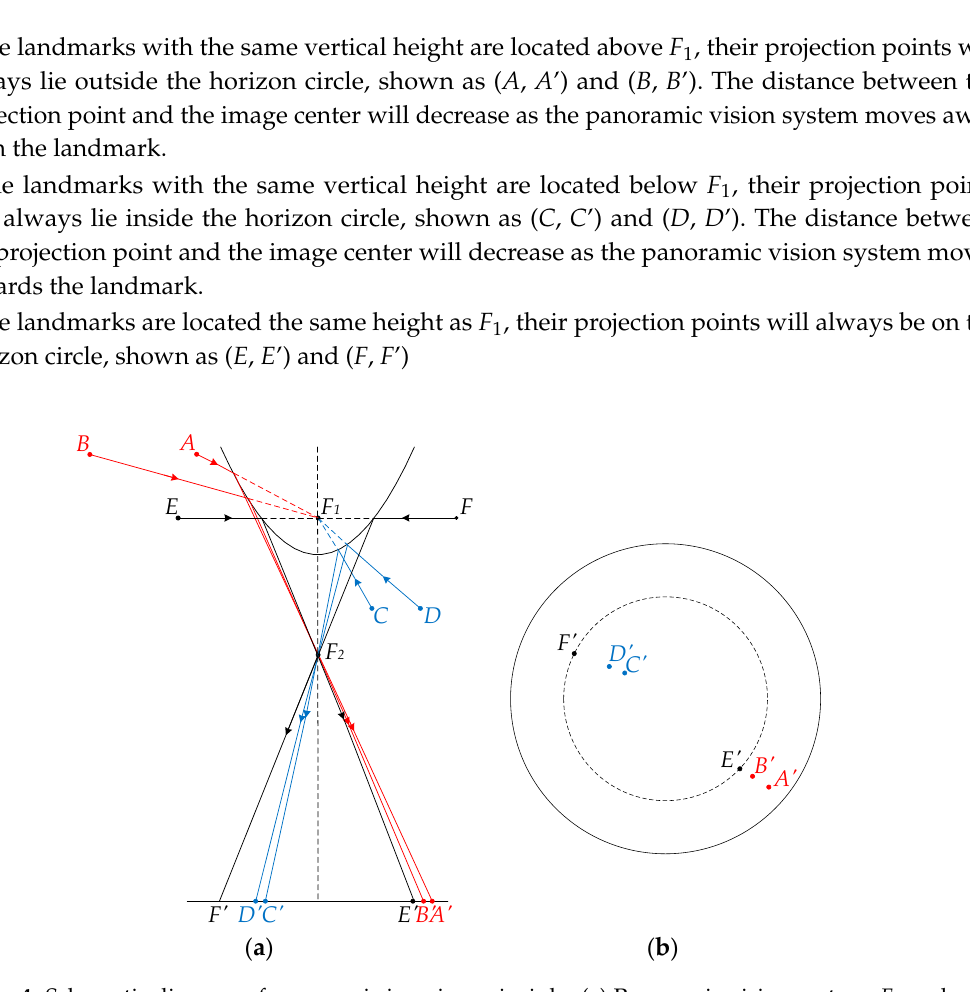
Figure 4. Schematic diagram of panoramic imaging principle. ( a ) Panoramic vision system: F 1 and F 2 are the foci of the panoramic vision system. A – F are six landmarks in the real scene. The vertical heights of A and B , C and D , and E and F are, respectively, the same, where A and B are above F 1 , C and D are below F 1 , and E and F are the same height as F 1 . A ’– F ’ are the corresponding projection points on the imaging plane. ( b ) Top view of the imaging plane: The dotted circle is denoted as the horizon circle.